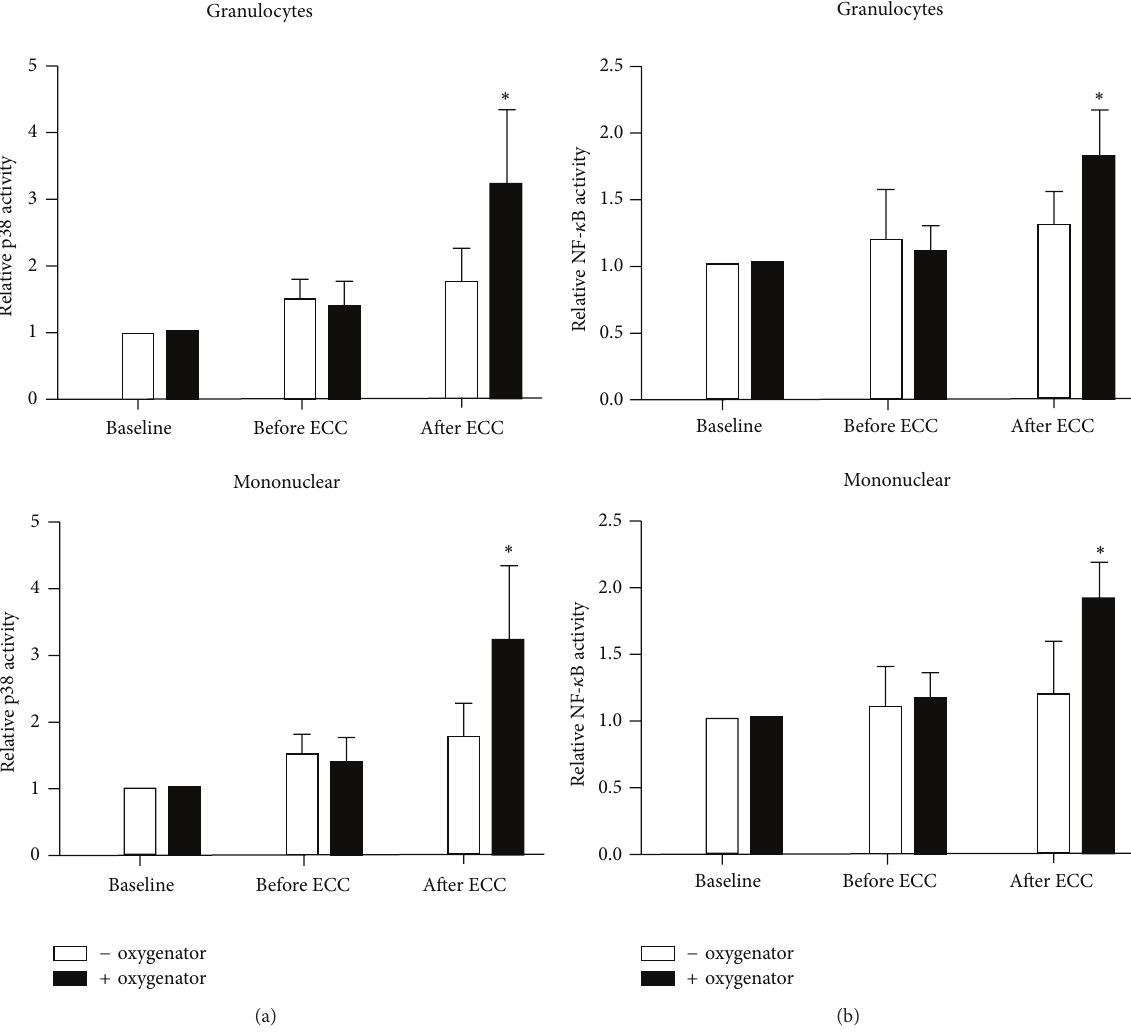
Figure 1: P38 and NF- 𝜅 B activation in leukocytes in response to ECC was significantly higher in presence of oxygenator. Peripheral blood samples were collected at baseline, before and after ECC. Leukocytes were fixed and permeabilized before intracellular staining using Alexa Fluor 568-conjugated antibodies that recognize (a) Thr180/Tyr182 phosphorylated p38 or (b) Ser529 phosphorylated NF- 𝜅 B or with isotype- matched antibodies as a control. After lysis of red blood cells, fluorescence of granulocytes or mononuclear cells was quantified by flow- cytometry (after gating of cells by size and granularity). Mean fluorescence levels were calculated after subtracting values from isotype-control antibodies. Mean values are shown with standard deviations. ∗ 𝑃 < 0.05 between the two groups at the same time